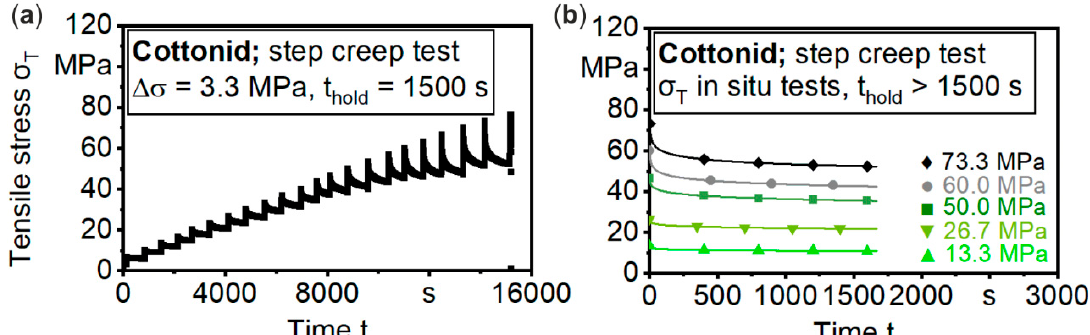
Figure 5. Assessment of relaxation behavior ( a ) stepped creep test; and ( b ) single creep tests for different tensile loads with functional fit.